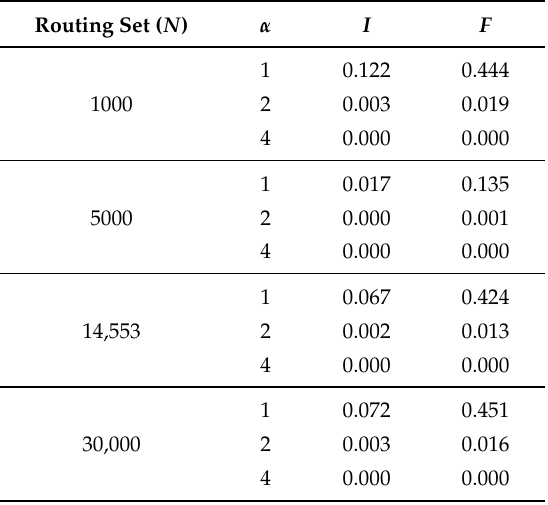
Table 3. Indeterminable and False port return